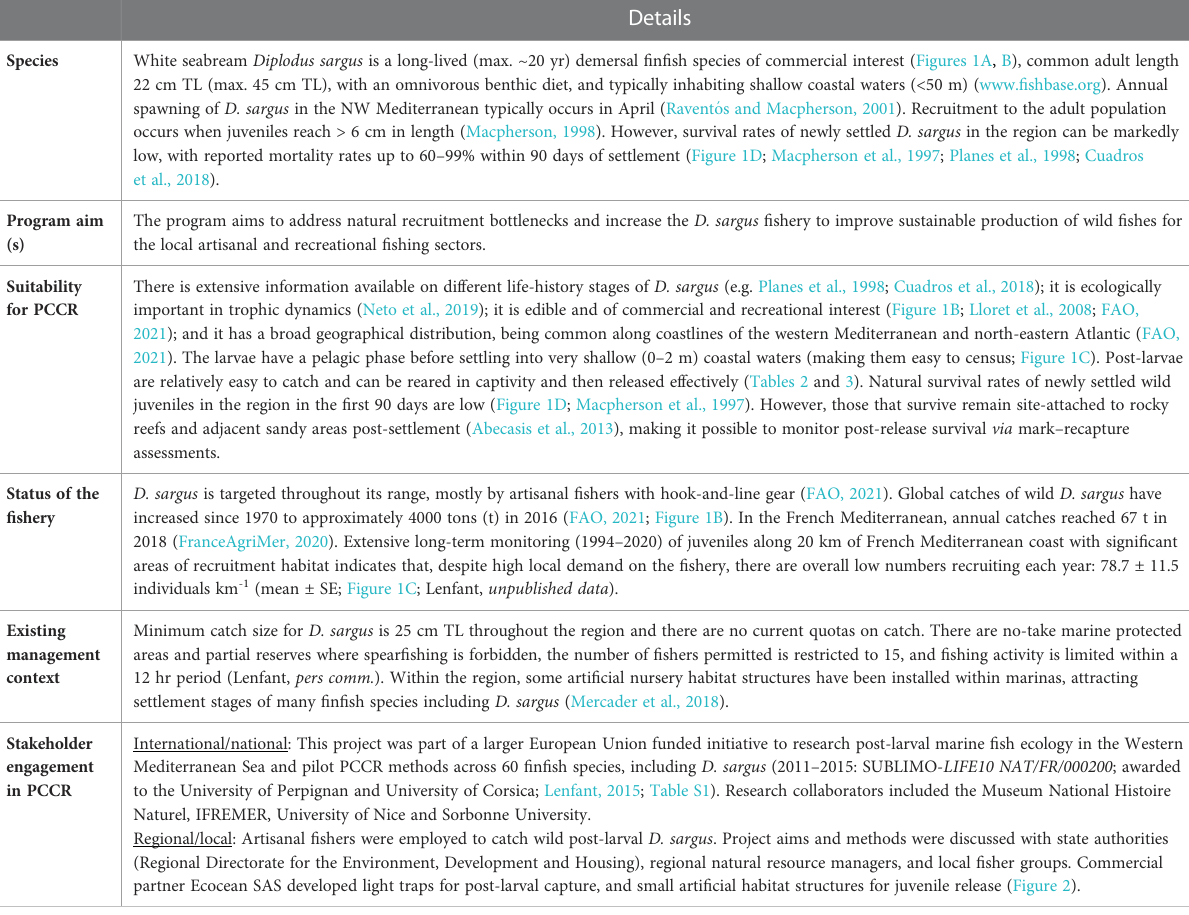
TABLE 1 ‘ Identifying the need ’ – Case study: Diplodus sargus in the French